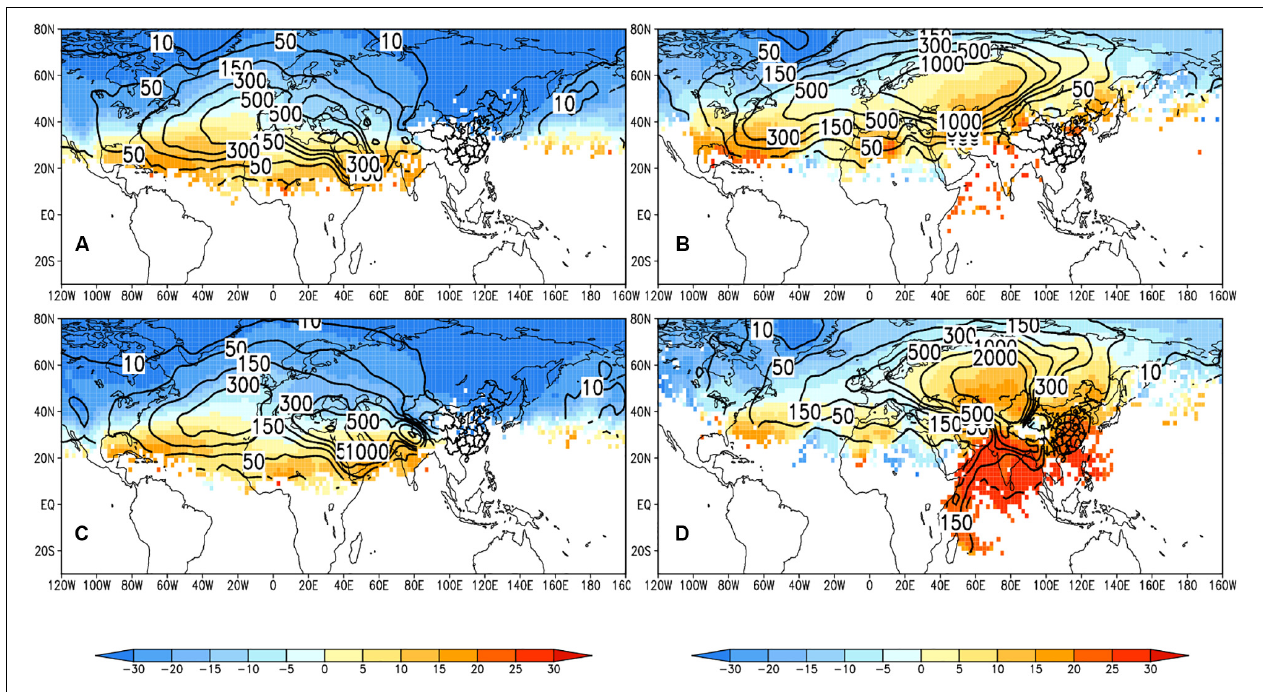
FIGURE 4 | Spatial distribution of the specific humidity carried by air parcels on day 10 before arriving in (A,B) region I and (C,D) region II of Central Asia in (A,C) winter and (B,D) summer during the time period 1979–2017. Contours for the number of air parcels weighted by specific humidity in g kg − 1 ; shading for the temperature of air parcels in ◦